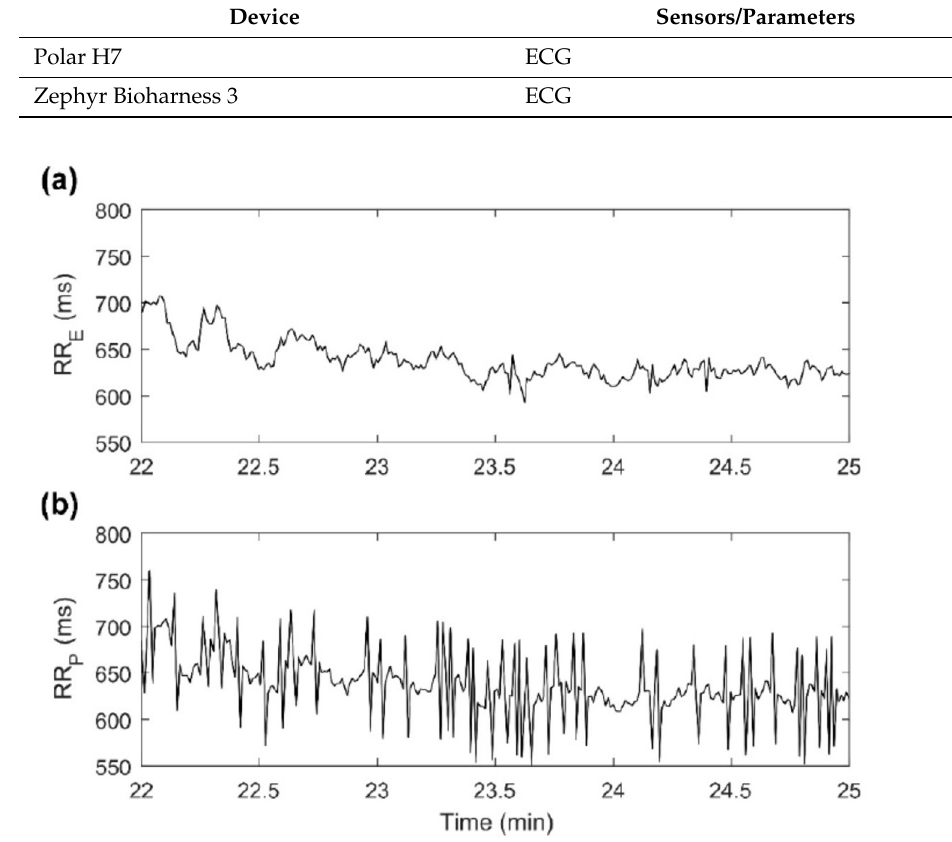
Table 6. Examples of wearable consumer grade chest strap cardiac monitors.